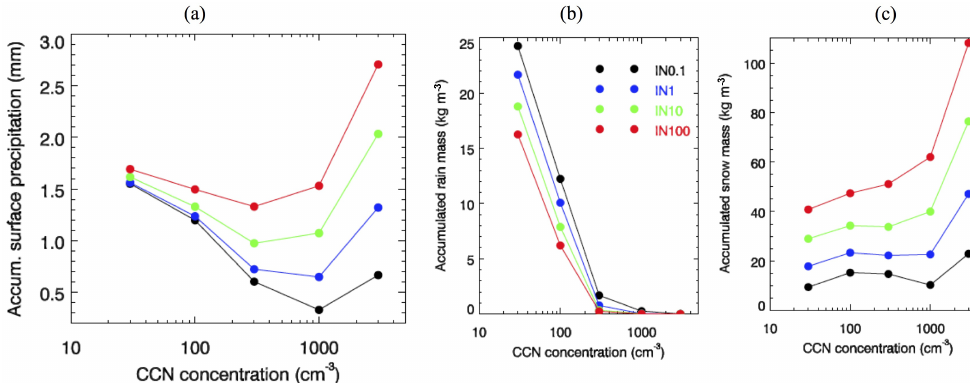
Figure 14. Same as Fig. 2, except for the WMOC.